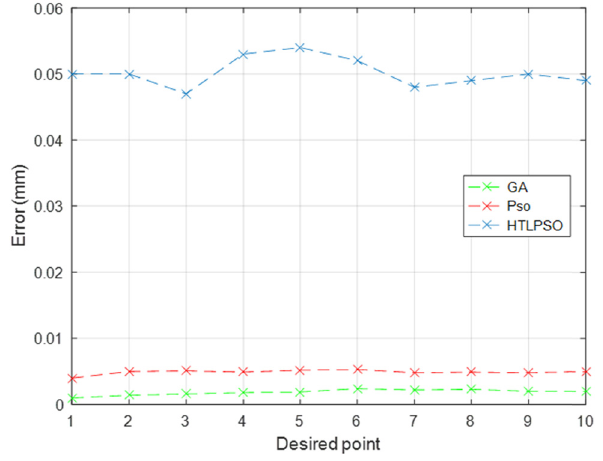
Figure 6: Evolution of error as function of desired points.